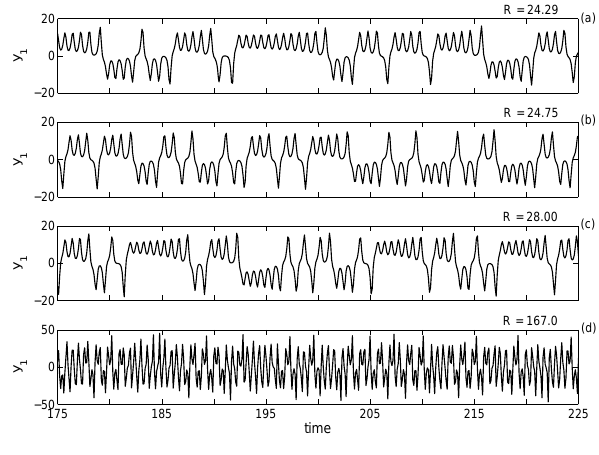
Fig. 8. Subsections for time series from the Lorenz equations for different choices of R